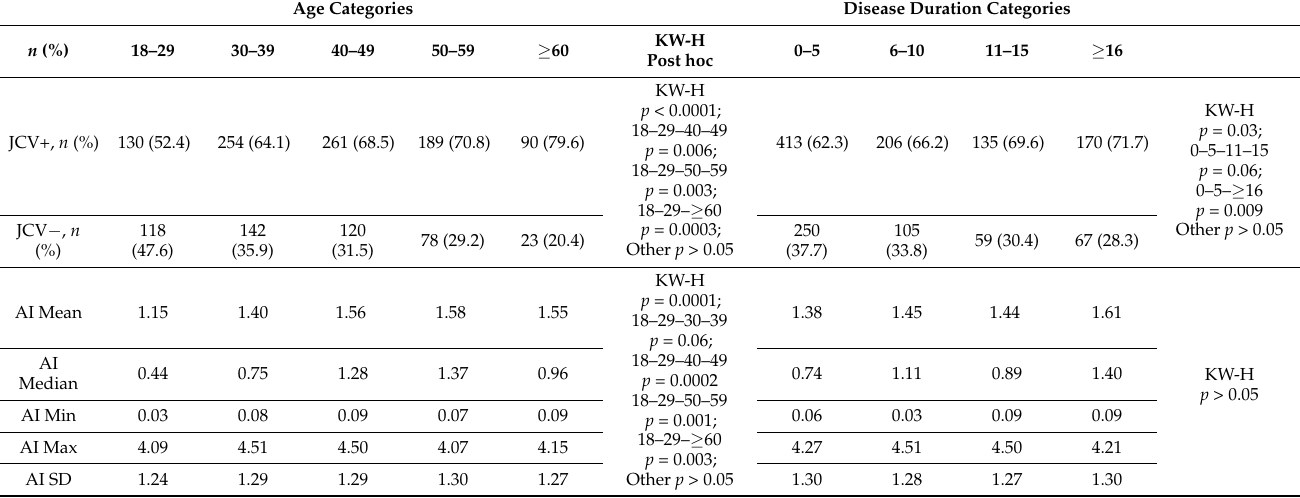
Table 3. Anti-JCV Ab prevalence and antibody index by patients’ age and disease duration